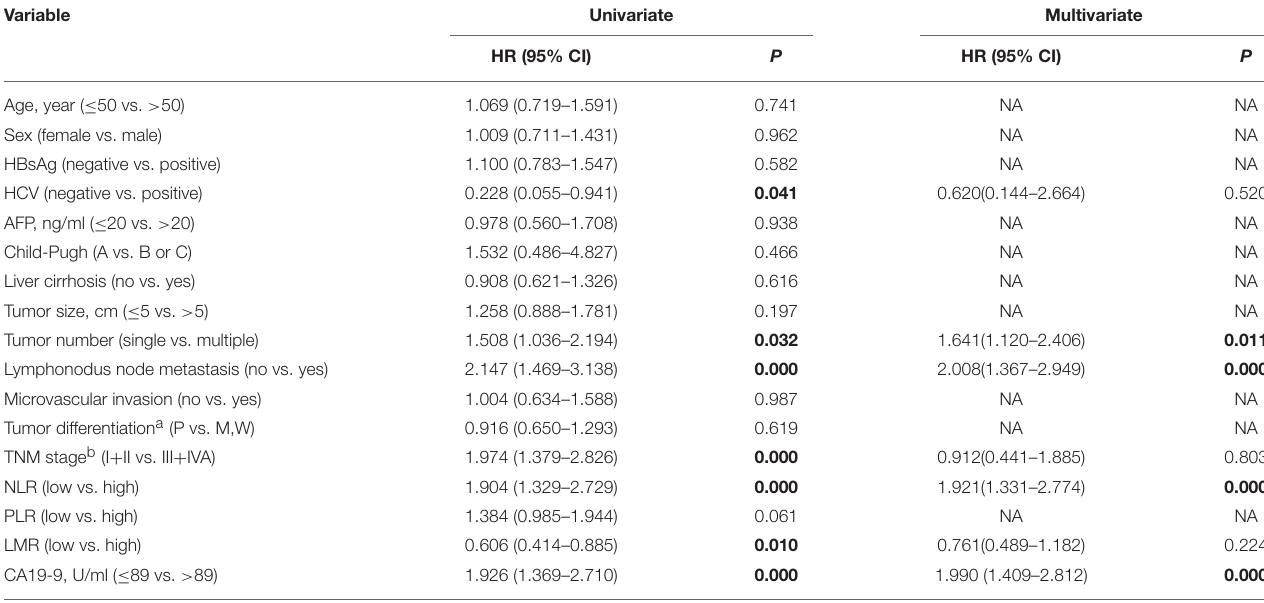
TABLE 3 | Univariate and multivariate cox regression analyses of factors associated with overall survival in patients who were relapse at 2 years after resection with curative intent for intrahepatic cholangiocarcinoma ( n = 168). Variable Univariate Multivariate